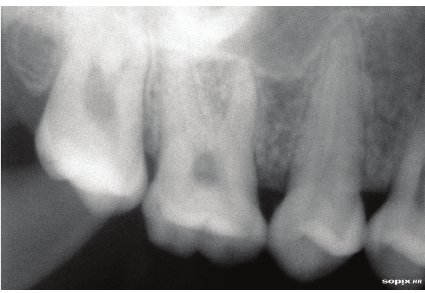
Figure 8: Maxillary second molar with an enlarged pulp chamber.